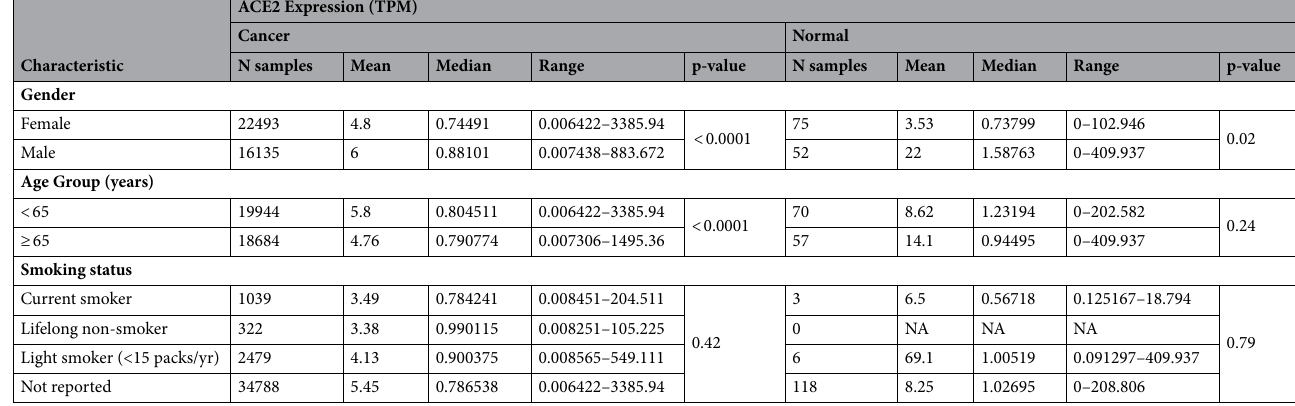
Table 1. ACE2 expression associated with patient demographics of normal control and cancer cohorts. P-values were calculated using the Kruskal–Wallis rank sum test for numeric variables and Pearson’s Chi- squared test for categorical variables.